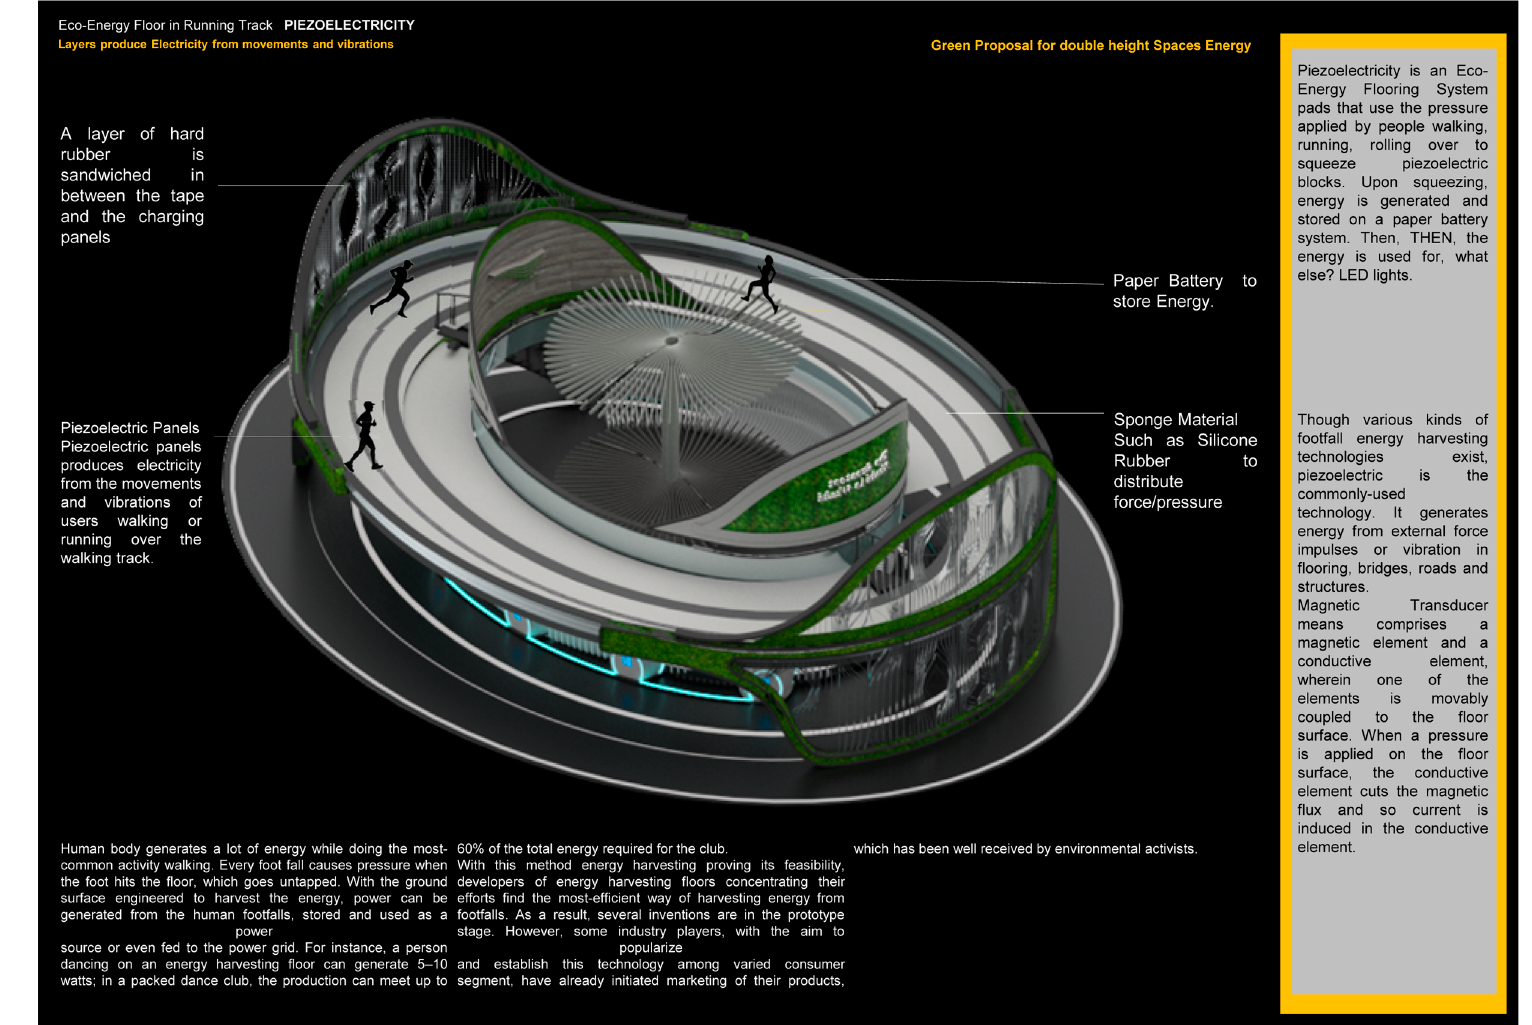
Figure A3 . Samples of the posters (Poster3) displayed on 6 February 2022 on DAU campus in the CADD Female Exhibition.